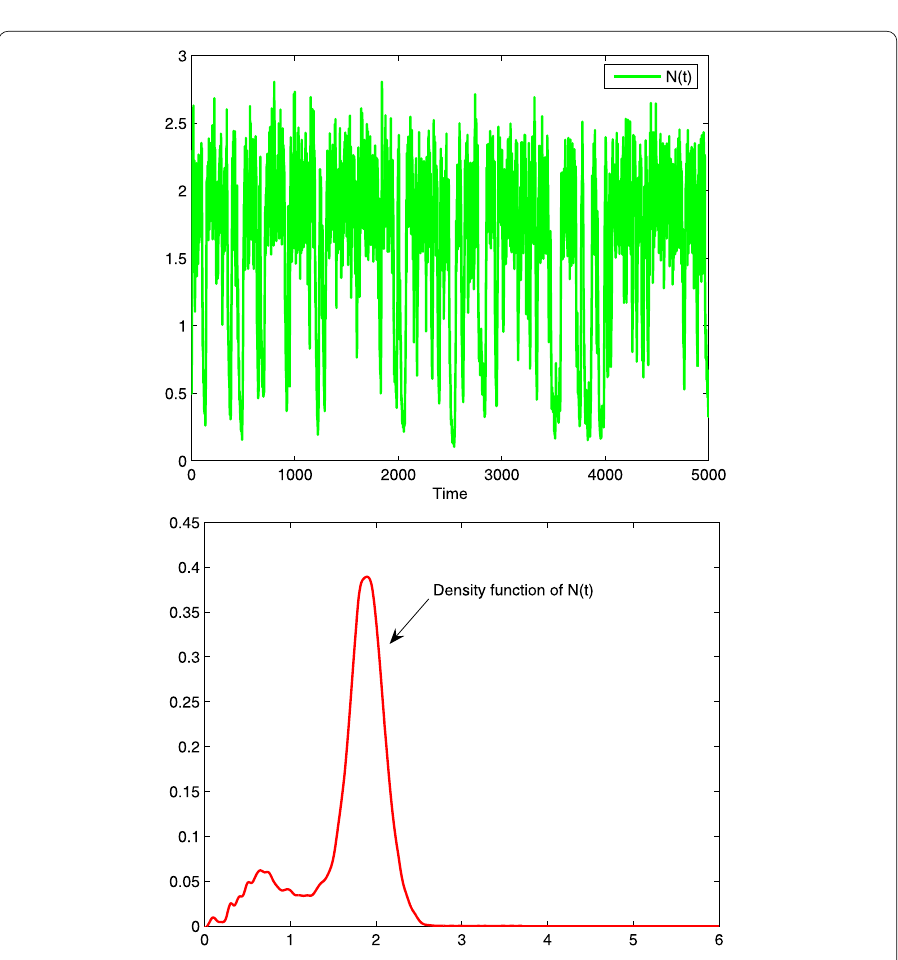
Figure 4 Hybrid system (16) with parameter values given in Fig. 1 and Fig. 2, and φ = (0.2,0.8). ( a ) is a trajectory of the system which suggests that the system is persistent; ( b ) is the density function of the solution of the system t =